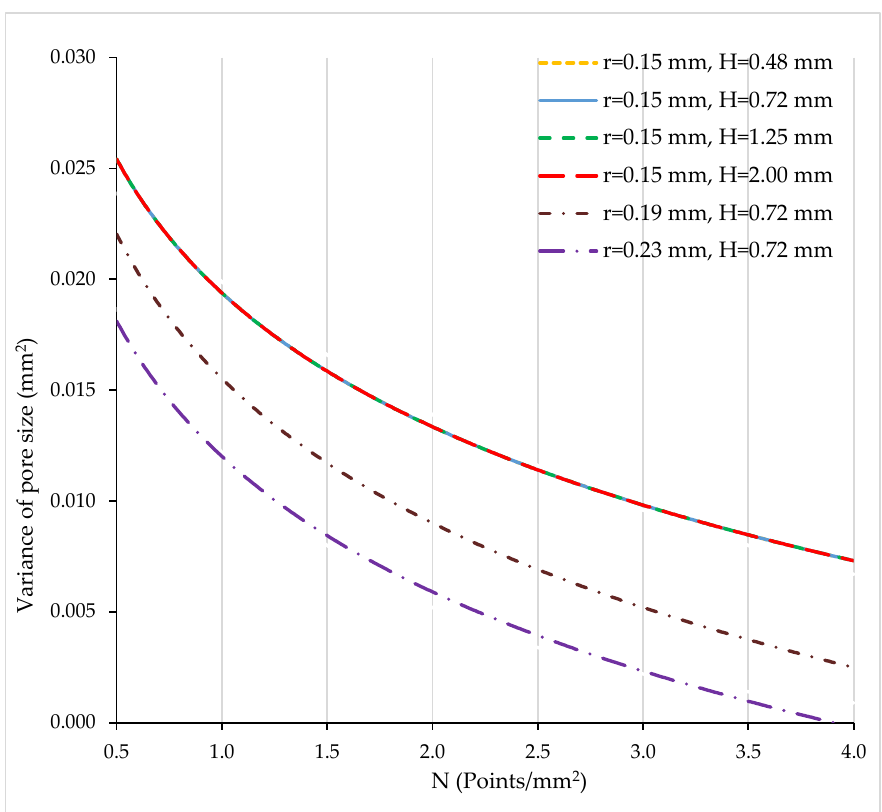
Figure 7. Variance of pore size (mm) vs. N (points/mm 2 ).